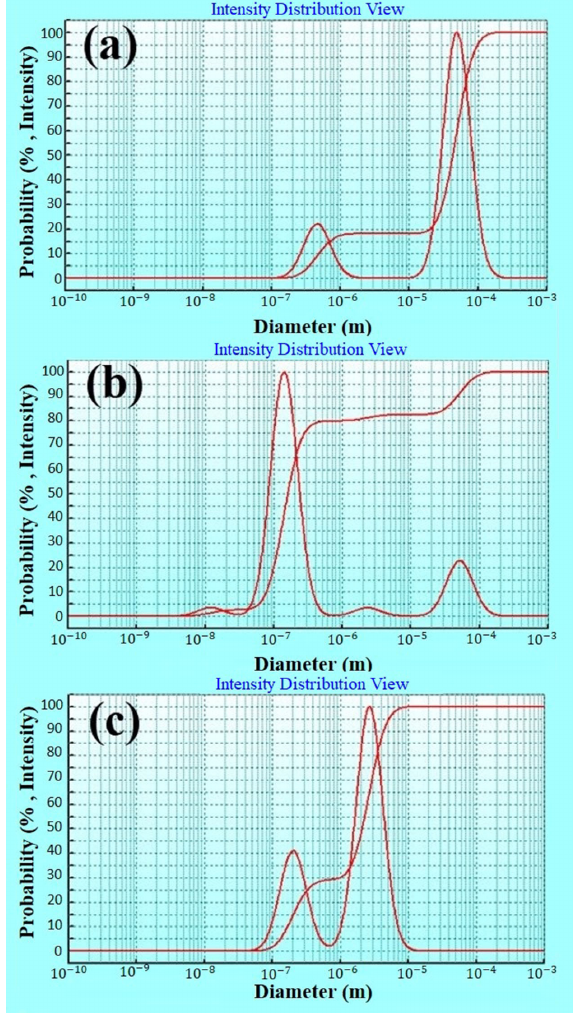
Figure 2. Particle size distribution of complex carriers containing vitamin B 12 at ( a ) pH = 3, ( b ) pH = 6, and ( c ) pH =